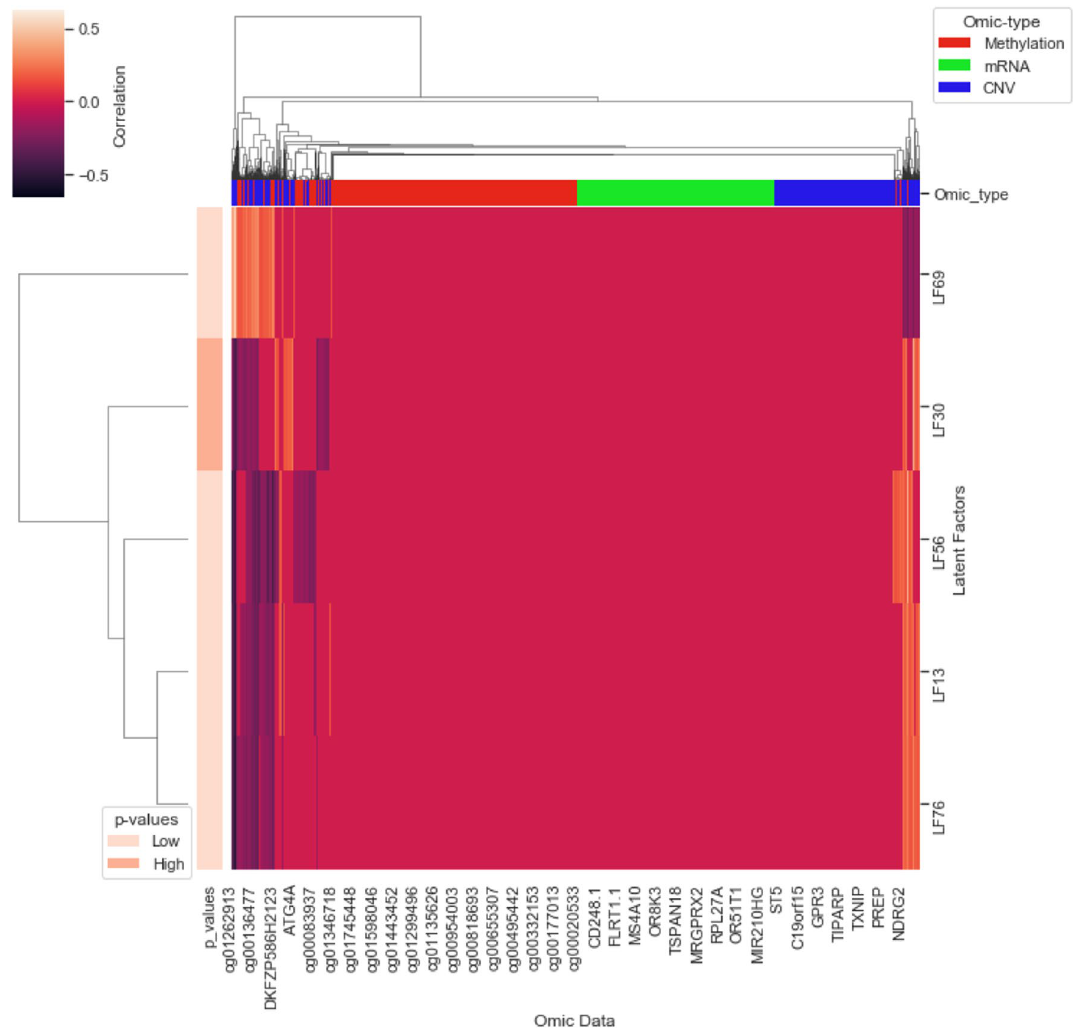
Figure 5. Association between CRLFs and input features: Input features of CNV_mRNA_methylation omics data are clustered based on the correlation data with the identified CRLFs. For example, the NDRG2 gene has strong correlation with LF30 and